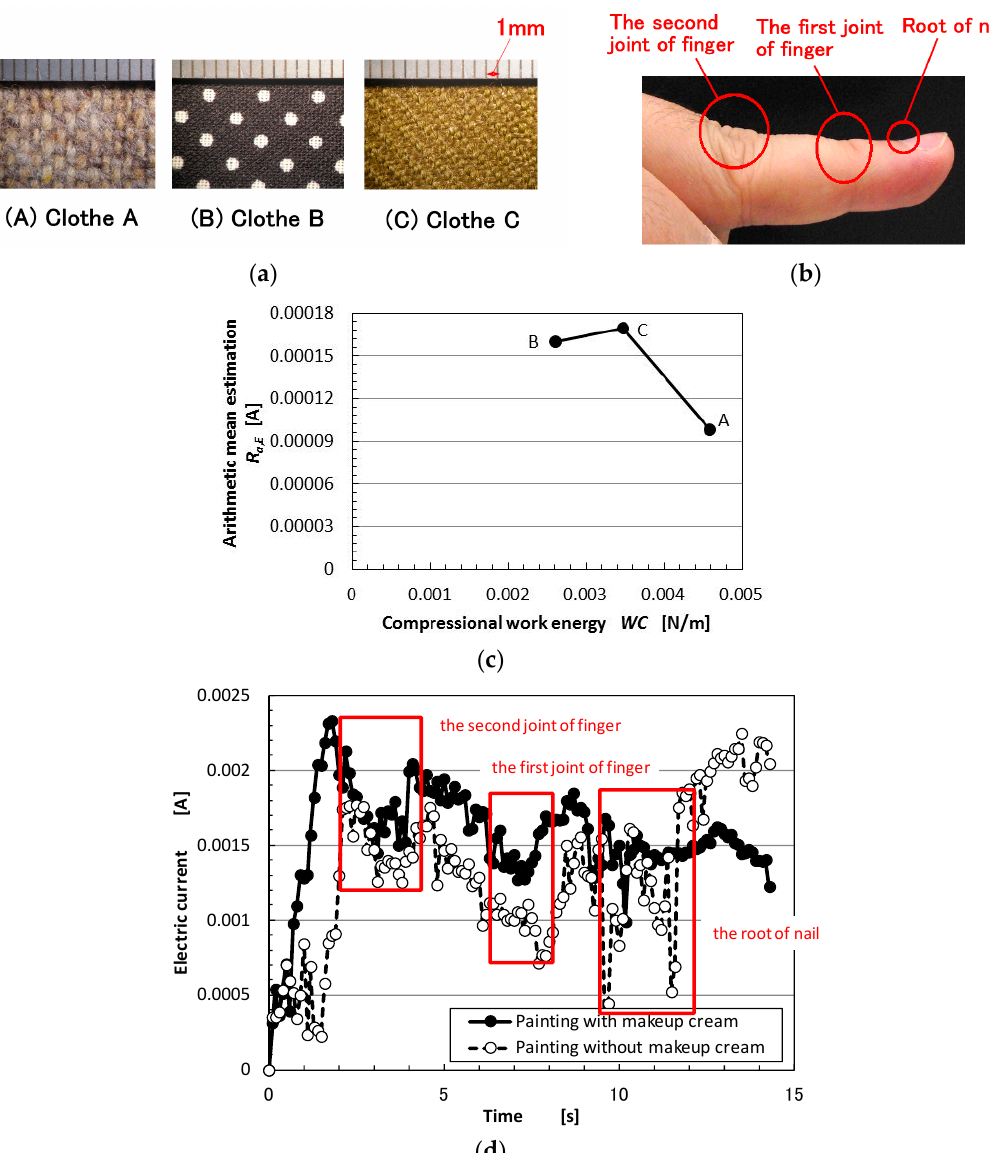
Figure A4. Photographs and results of measured surface roughness of varied body with softness by dry-type MCF rubber: ( a ) the photographs of cloth; ( b ) the photograph of finger; ( c ) the results in the case of ( a ); ( d ) the results in the case of ( b ) [28].